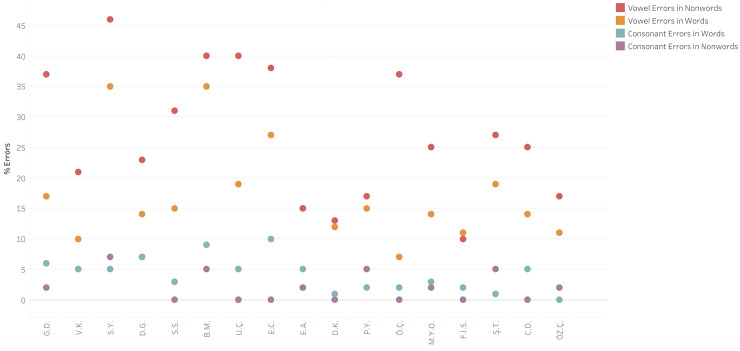
Percentage vowel letter errors (red and orange) and consonant letter errors (turquoise and purple) in reading words and nonwords per participant.